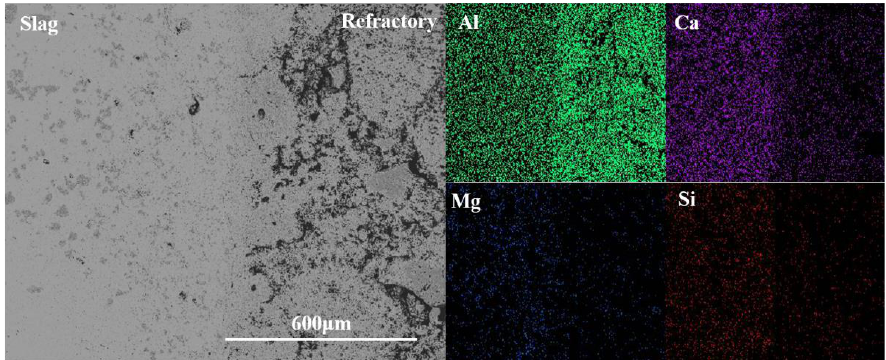
Figure 8. Element mapping of the slag-crucible interface of CA 6 -Al 2 O 3